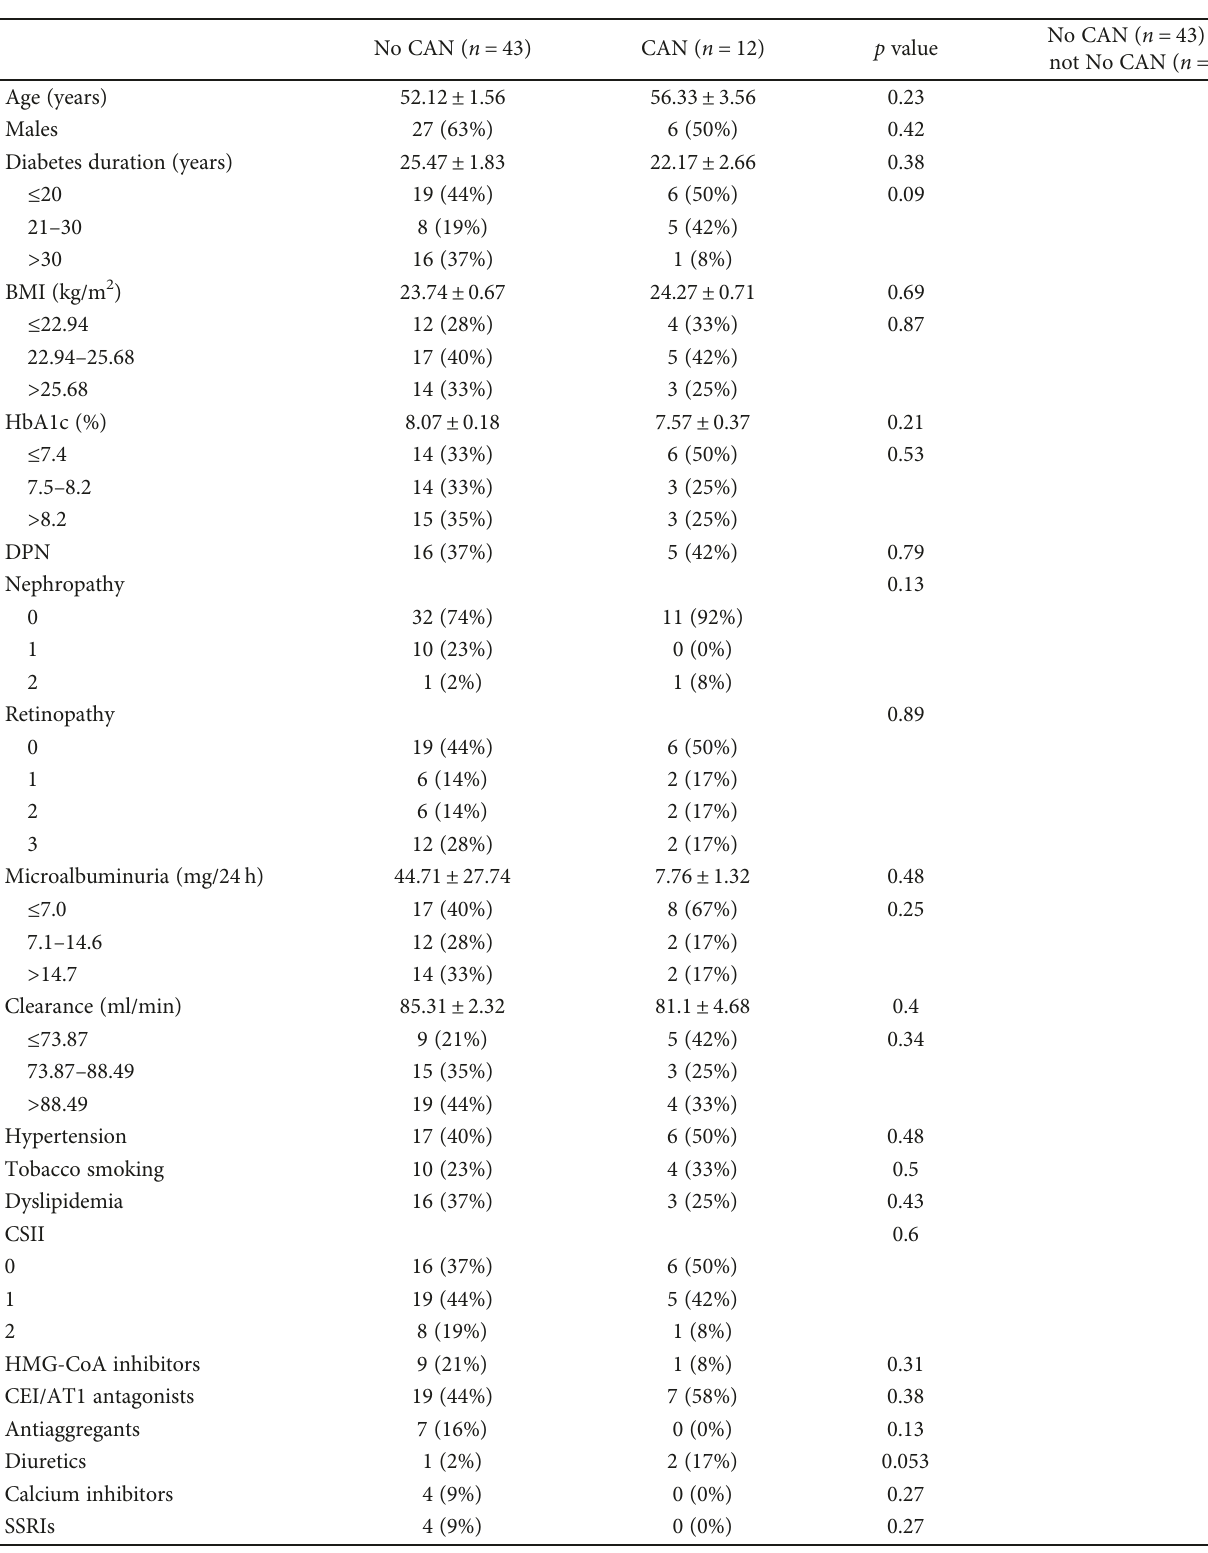
Table 3: Baseline clinical and biochemical characteristics of type 1 diabetic patients without CAN at inclusion who remained stable (no CAN) or developed autonomic dysfunction (CAN) for over a mean period of 3